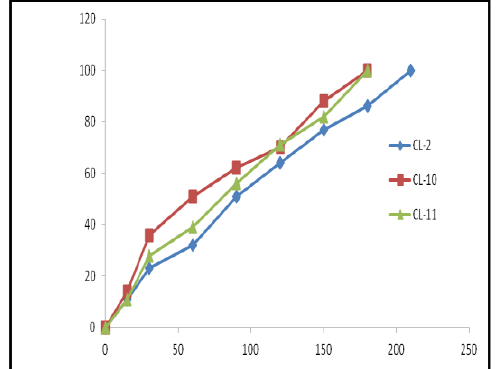
Figure6: The effect of diluent type on the release of clopidogrel in 0.1N HCl and